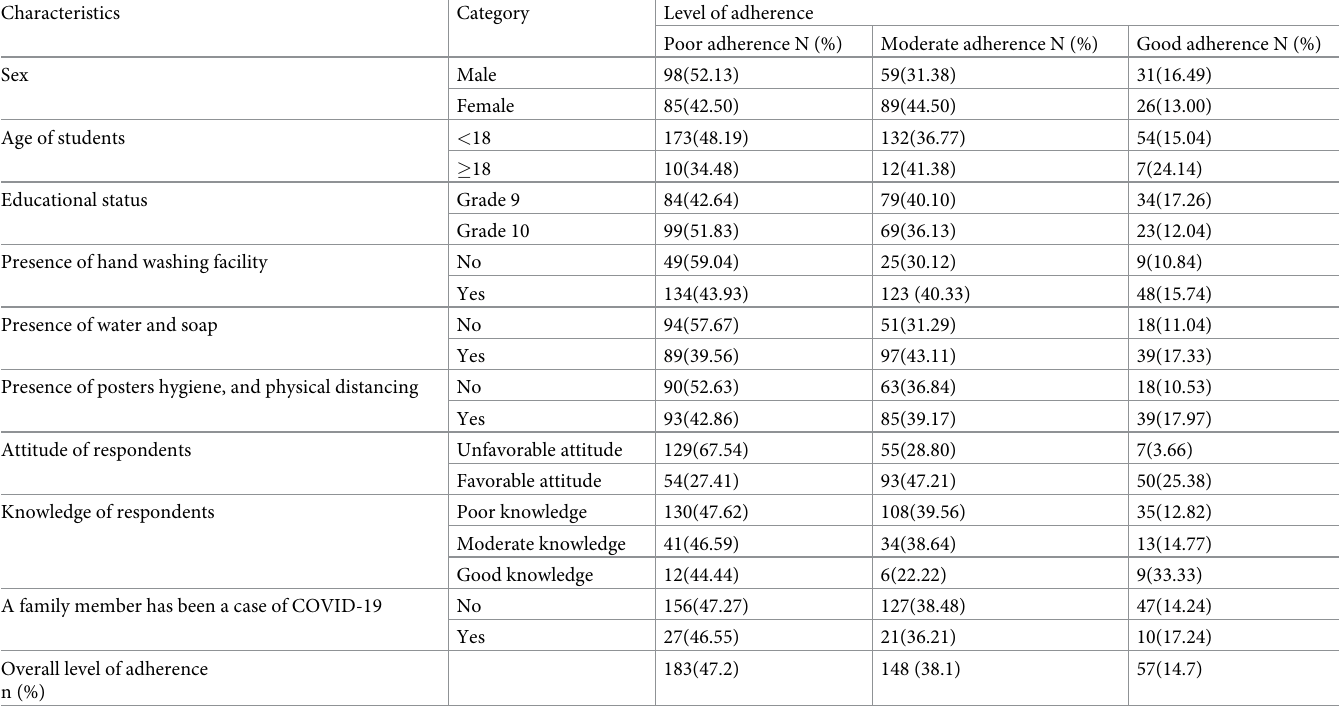
Table 5. The level of COVID-19 preventive adherence students of Jimma town public high schools, southwest Ethiopia/2021 (n = 388).